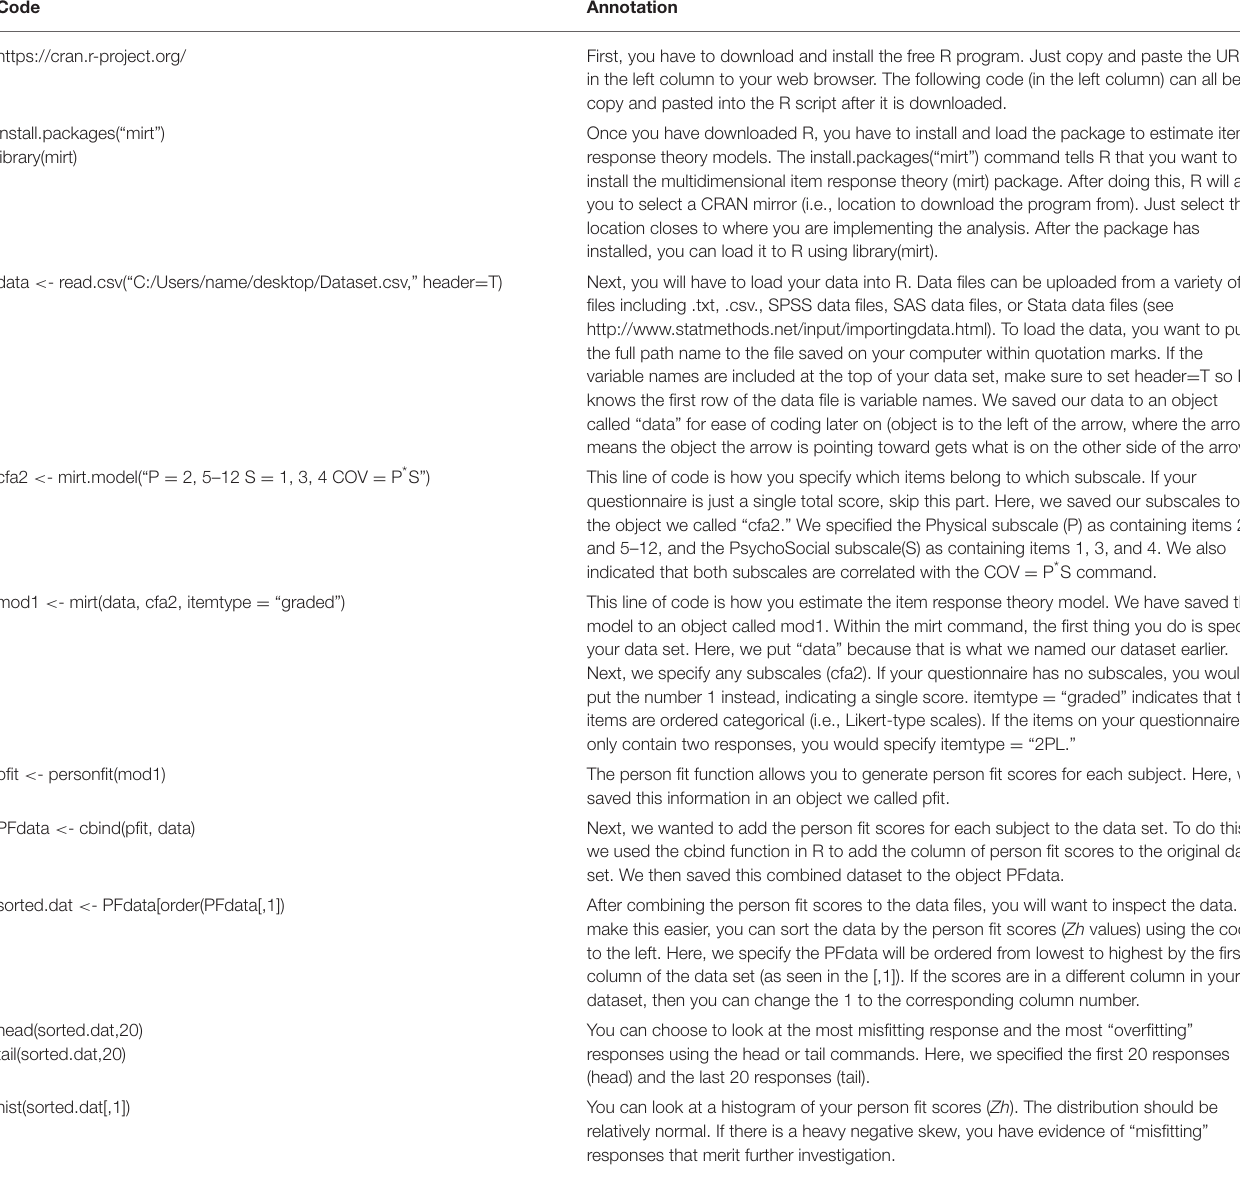
TABLE 3 | Statistical Code for outlier detection using the Person Fit method.